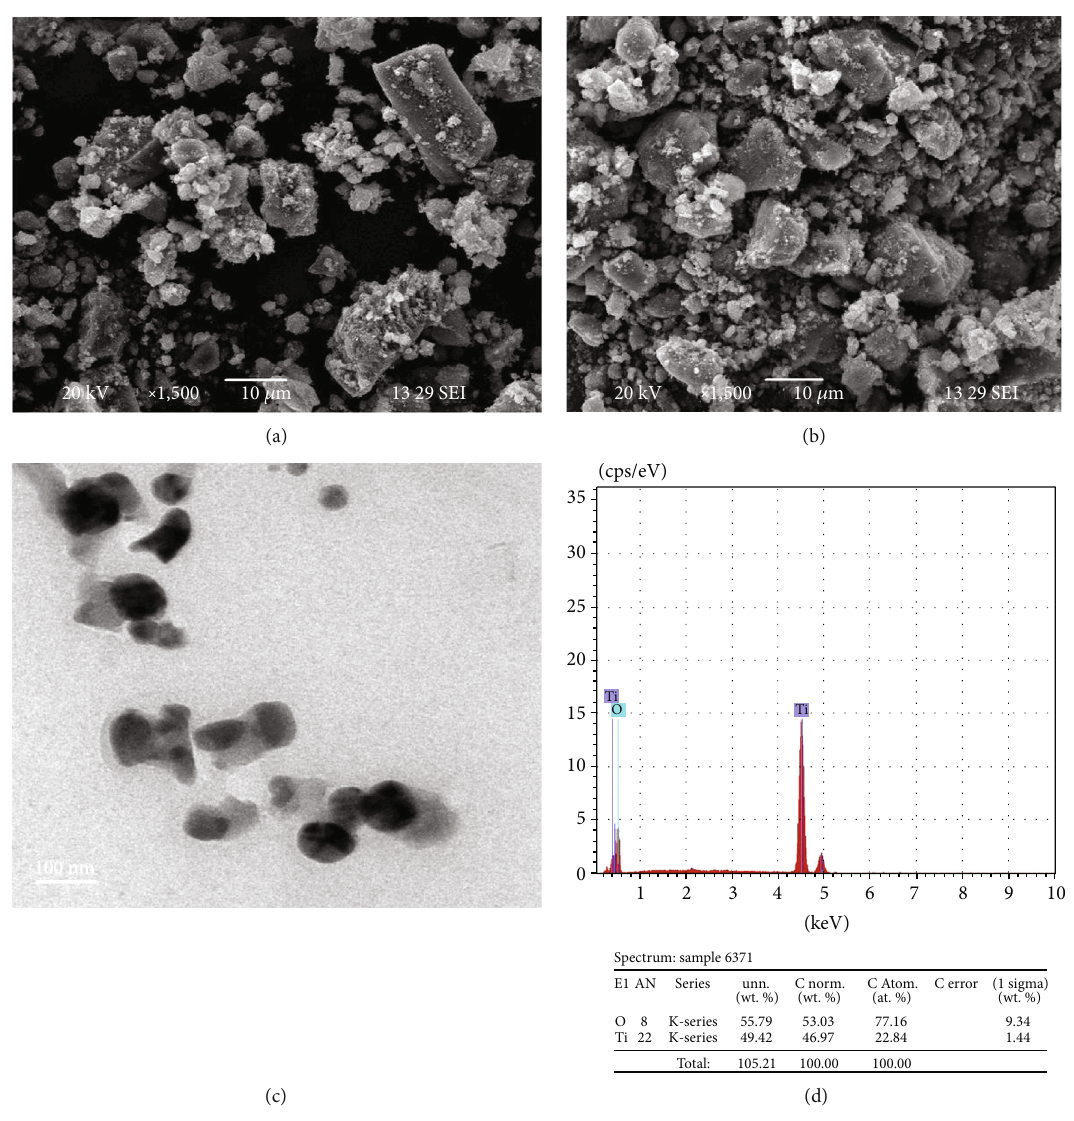
Figure 7: (a and b) TiO